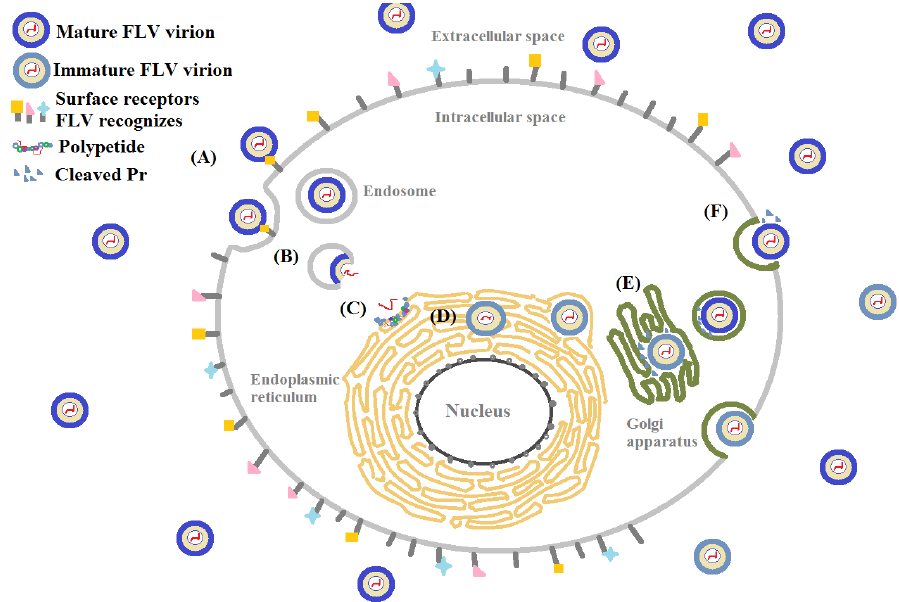
Figure 2. Host cell entry of flavivirus (FLV) ( A ) adsorption and ( B ) internalization confirmation change of envelope protein triggers membrane fusion and viral genome release; ( C ) replication and ( D ) translation beginning of N -linked glycosylation and viral assembly in the endoplasmic reticulum; ( E ) completed glycosylation and pre-membrane (prM) protein is cleaved to become a mature virion in the Golgi apparatus; ( F ) exocytosis of a mature virion.